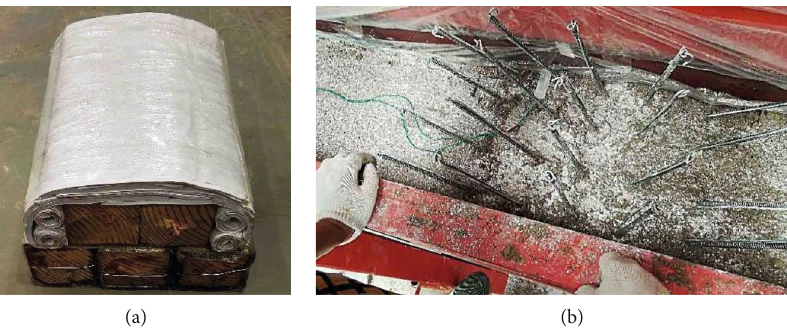
Figure 3: Roadway fi lling body and supporting structure. (a) Roadway model. (b) Roadway